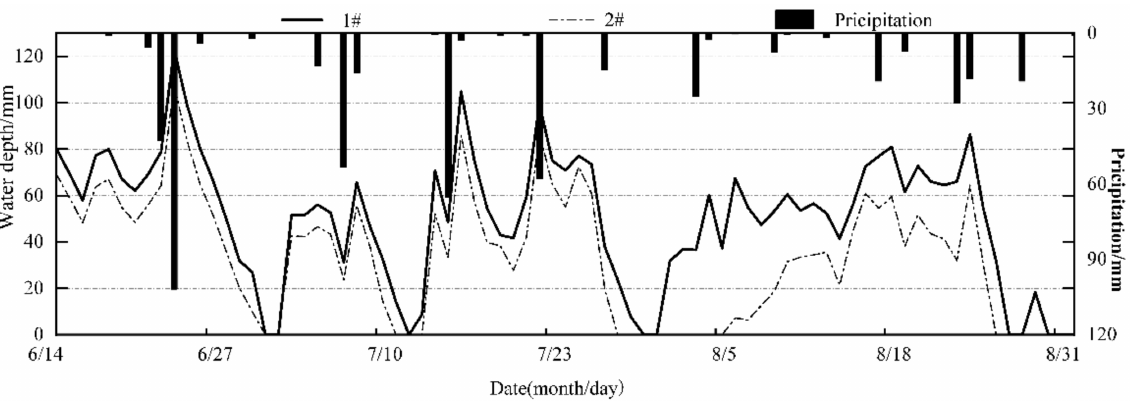
Figure 2. Growing period division, water depth and hyetograph of points 1# and 2# in paddy fields.